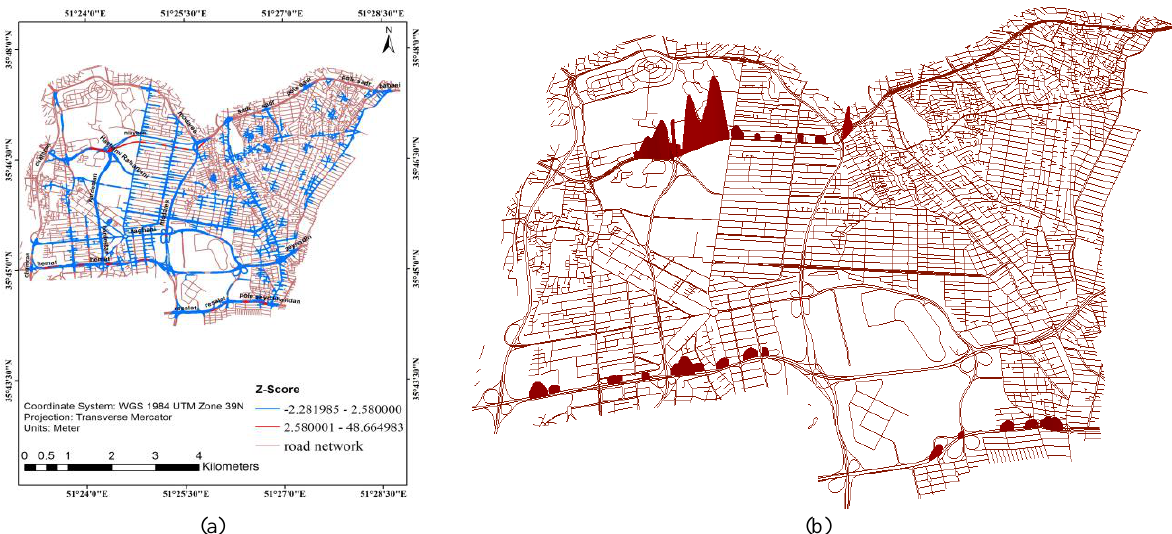
Figure 9. The vulnerability map of the accident-prone segments resulting from the integration of NKDE method (discontinuous kernel function) and Network-Constrained Getis-Ord Gi* statistics based on Z-Score at 99% confidence level (a) 2D (b) 3D